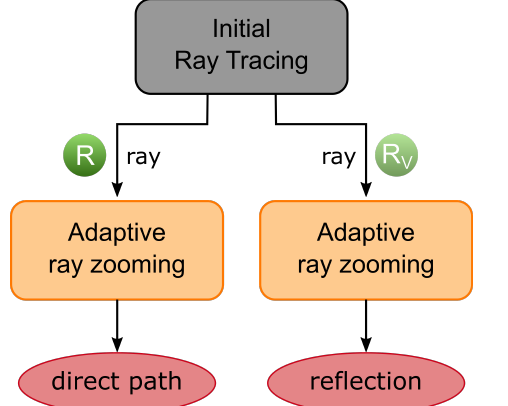
Figure 5. Block diagram of the overall approach to fi nd eigenrays of direct path and ground re fl ection.